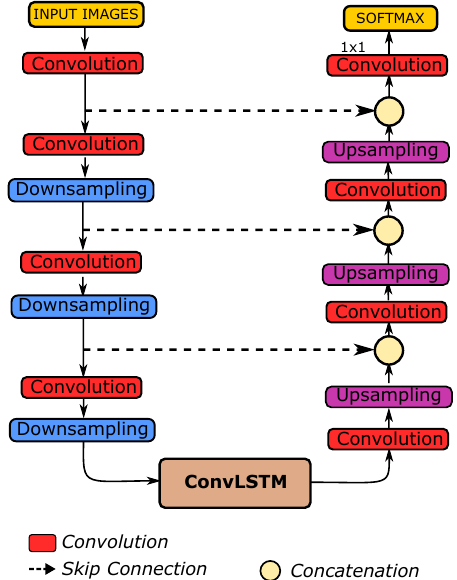
Figure 2. UnetConvLSTM architecture. Input is a sequence of images. The output corresponds to the class probabilities predicted for each pixel location in the last